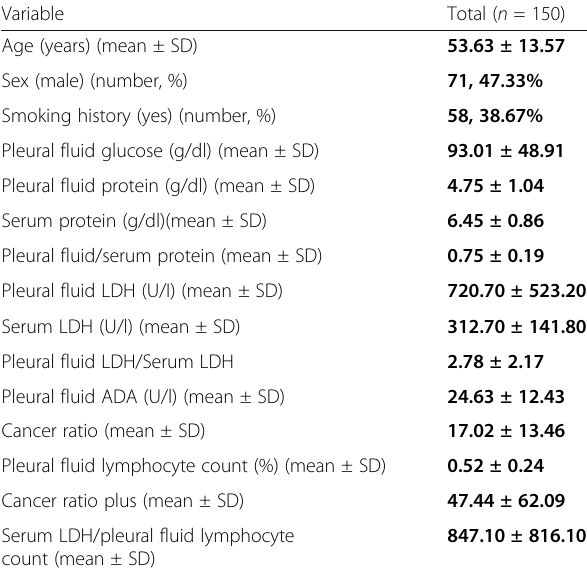
Table 1 Demography and pleural fluid characteristics of the studied patients